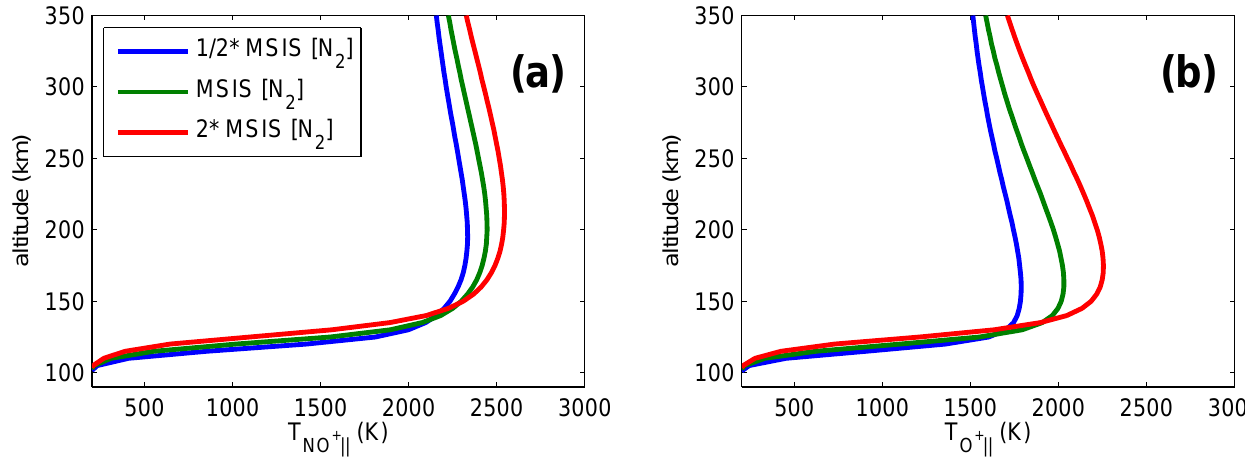
Fig. 2. Effects of varying the O/N 2 ratio on shapes of ion temperature profiles for dominant F-region species.